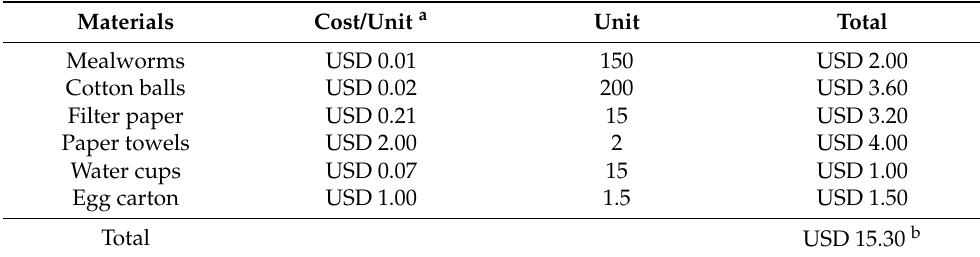
Table 2. Variable monthly expenditure for producing 20 P. maculiventris and 20 E. floridanus eggs to